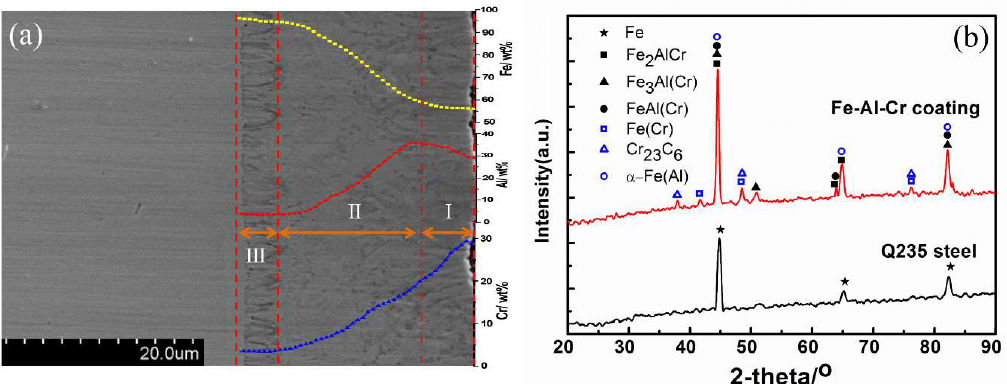
Figure 9. ( a ) The cross-sectional morphology and composition distribution (I: deposited layer, II: ff usion layer), and ( b ) XRD patterns of Q235 and Fe-Al-Cr coating. compound layer, and III: diffusion layer), and ( b ) XRD patterns of Q235 and Fe-Al-Cr coating. II: compound layer, and III: di